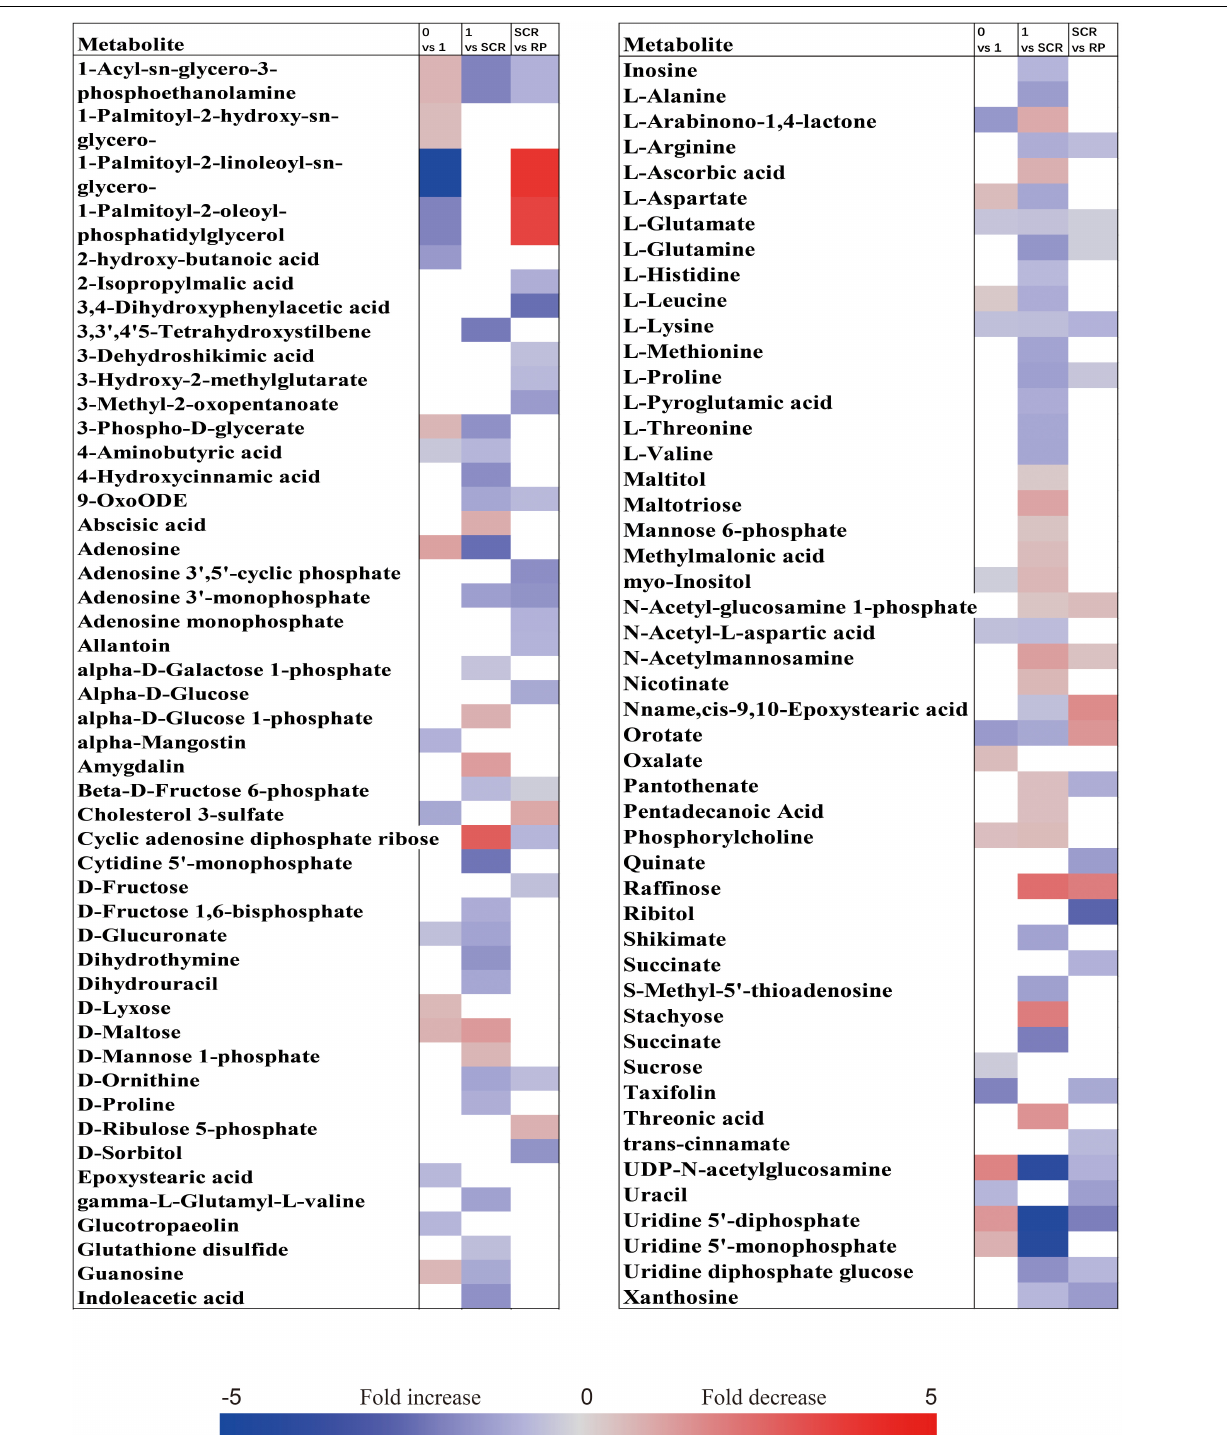
Frontiers in Plant Science |